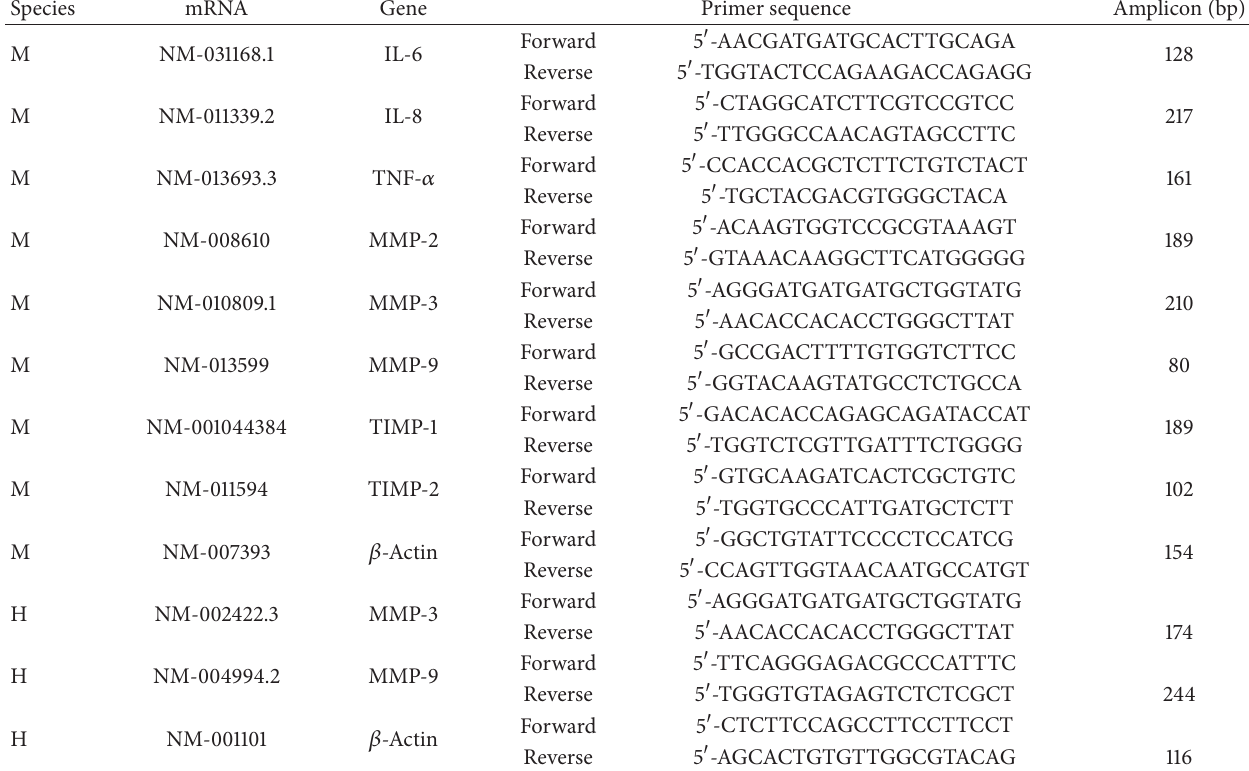
Table 1: Primers sequence for